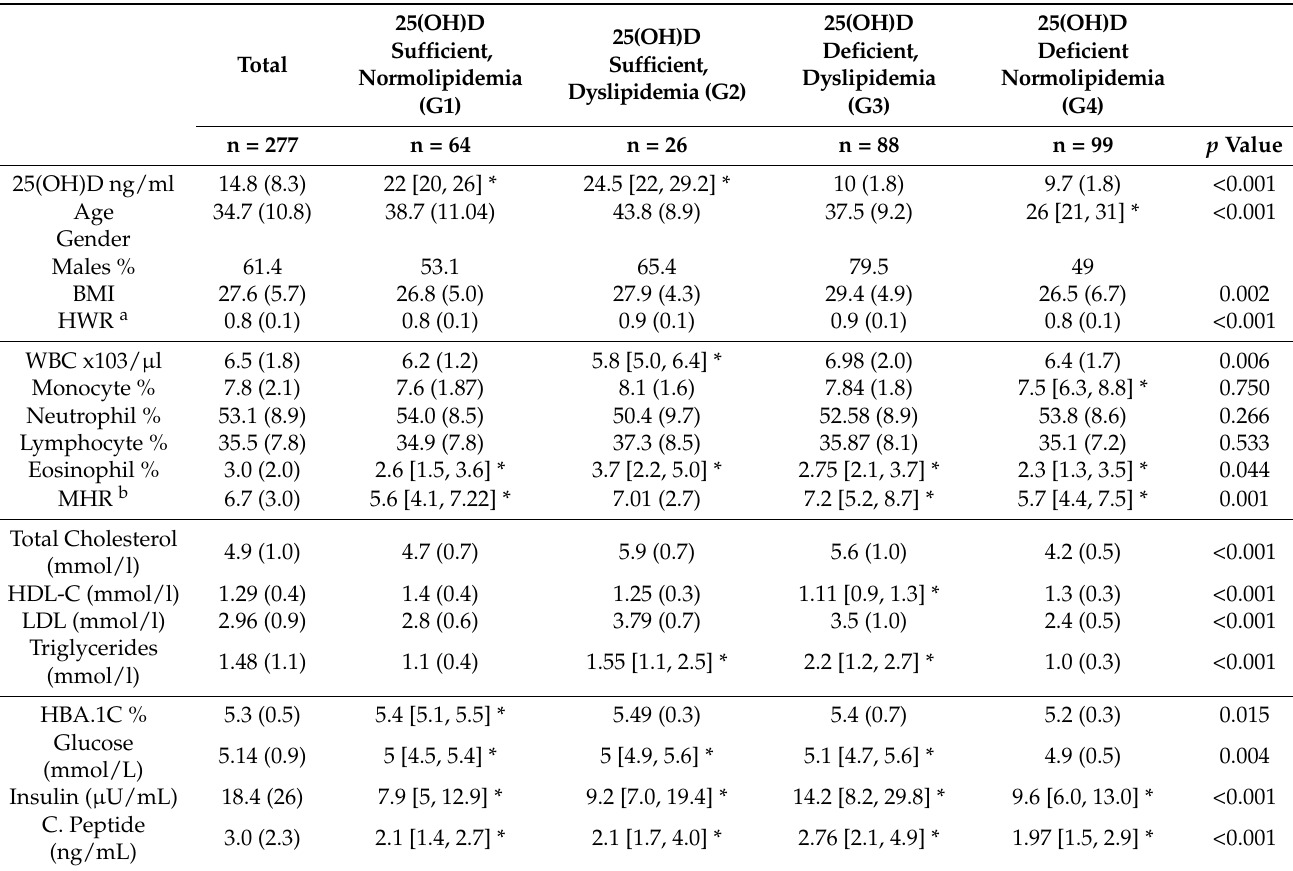
Table 1. Characteristics of the participants’ groups based on serum 25(OH)D concentrations and